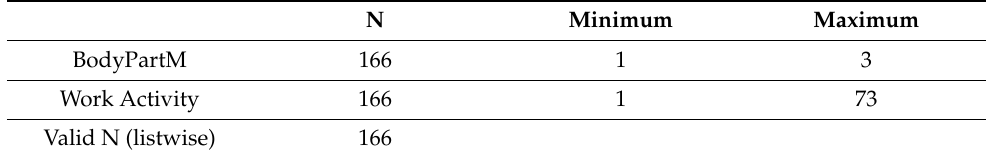
Table 5. Descriptive statistics: minimum and maximum.